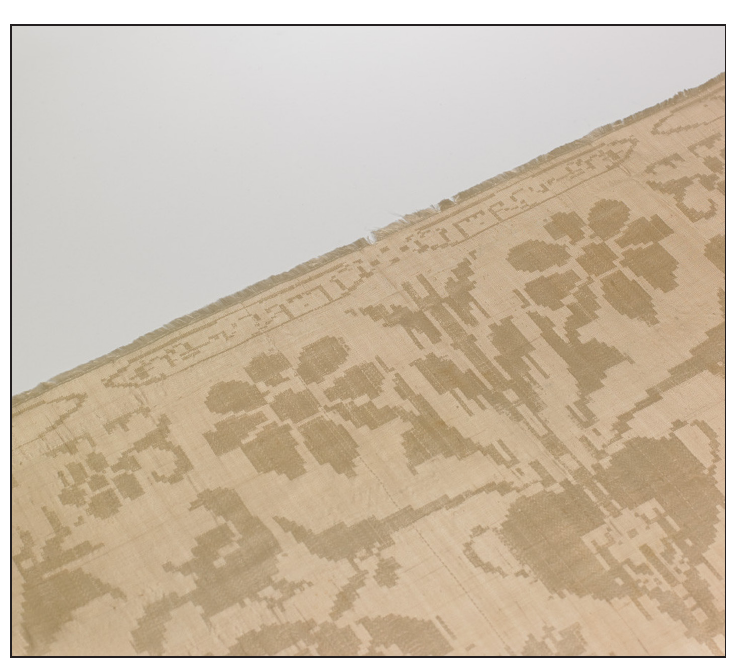
Fig. 9 : Fragment of brocade, silk, Iran (Kashan), nineteenth century. T15, given by Miss E. G. Tanner in 1927. © Holburne Museum, Bath. Photo: <www.tonygilbert.co.uk>.